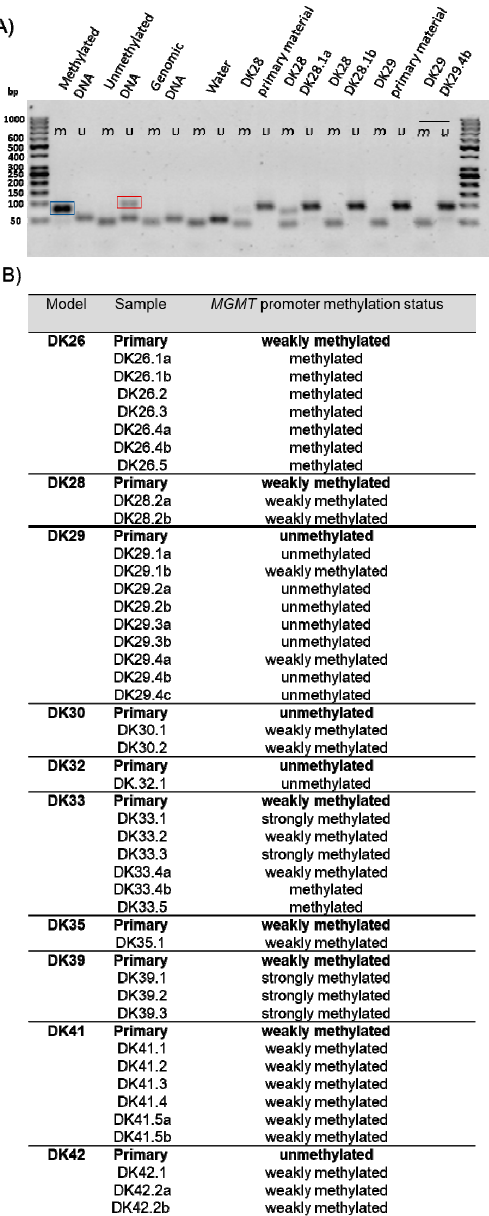
Figure 8. Semi-quantitative analysis of the MGMT promoter methylation. ( A ) Representative agarose gel with methylation-specific PCR (MSP). Blue square: fragment resulting from the amplification of a methylated template (M); red square: fragment resulting from the amplification of an unmethylated template (U). ( B ) Summary table of the semi-quantitative analysis of the MSP. For each sample, the M/U ratio was calculated. Samples were classified as unmethylated (M = 0), weakly methylated (0 < M / U < 1), and strongly methylated (M/U > 1). Samples with U = 0 were considered methylated.